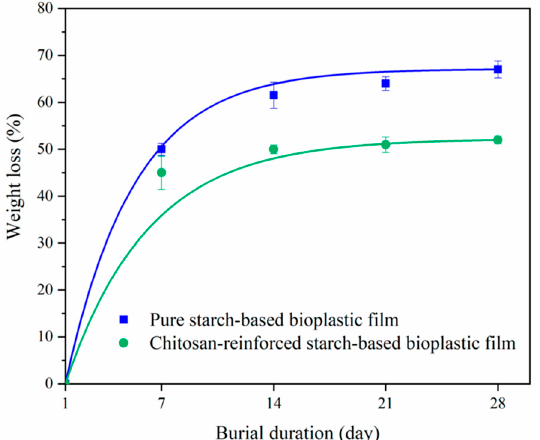
Figure 6. Weight loss percentages of biodegradable plastic films, based on starch and starch-chitosan, during a burial period. The figure was taken from the literature [18].